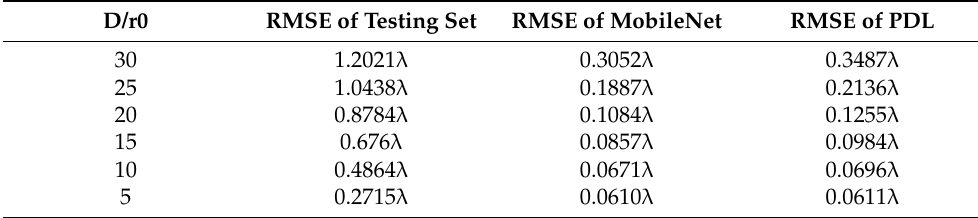
Table 4. Comparison of the accuracies (RMSE) of the equivalent wave-fronts from the Zernike coefficients estimated in the experiments between PDL and MobileNet with different D/r0 (3–64 orders).